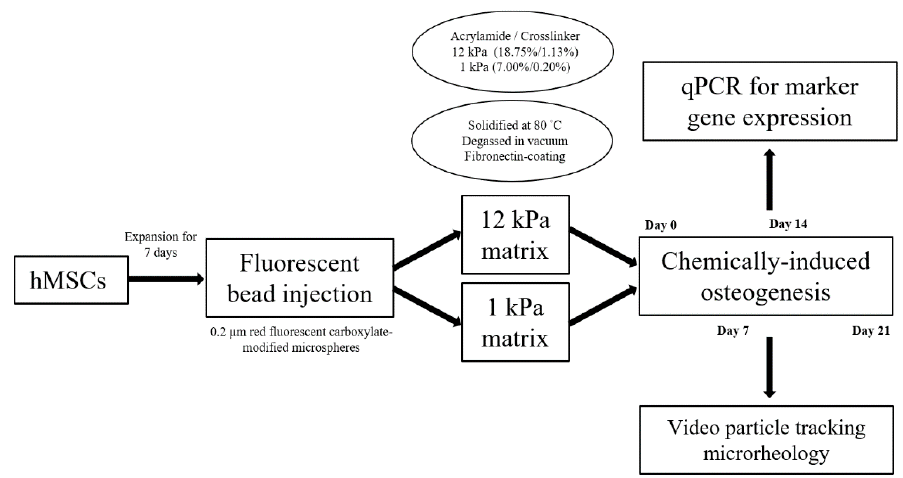
Figure A1. Study design. hMSC: human mesenchymal stem cell. qPCR: quantified polymerase chain reaction.